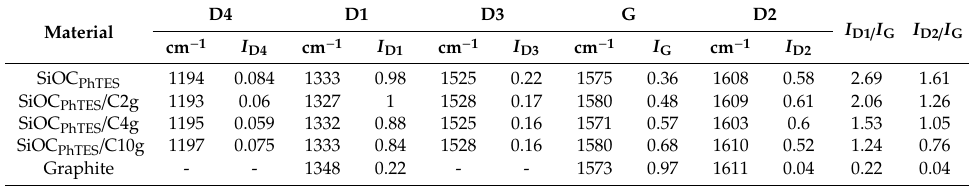
Table 3. Data obtained from the Raman spectra deconvolution of the investigated samples, band positions, band intensities ( I ) (height of the fitted peak) and intensity ratio ( I D1 / I G and I D2 / I G ).